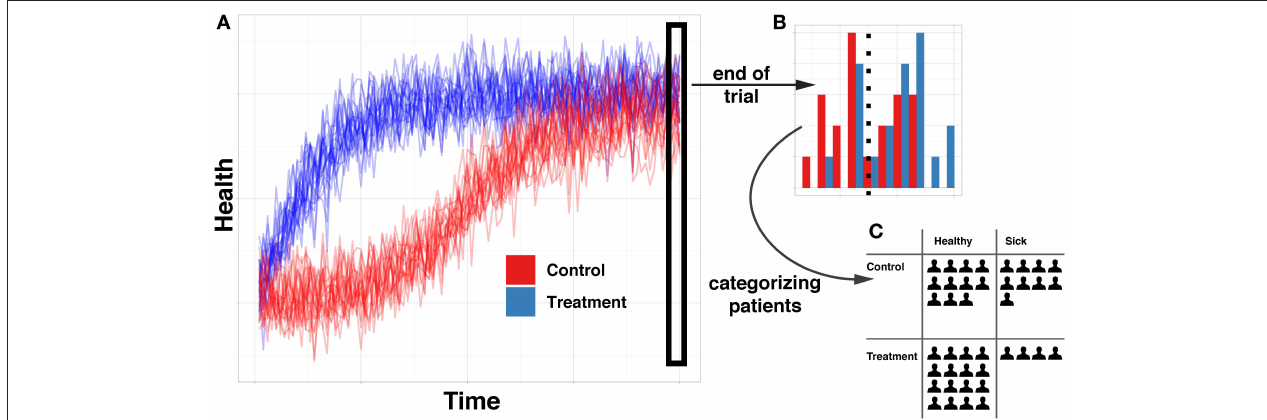
FIGURE 1 | Illustration of abstraction from full timeseries data to probabilistic contingency. (A) is a full time course of the health of 40 simulated patients throughout the course of a classic randomized controlled trial. (B) demonstrates the type of information available when only evaluating the health of patients at the end of the trial. (C) demonstrates the type of information available when categorizing patients into “sick” and “healthy” groups, rather than maintaining full continuous